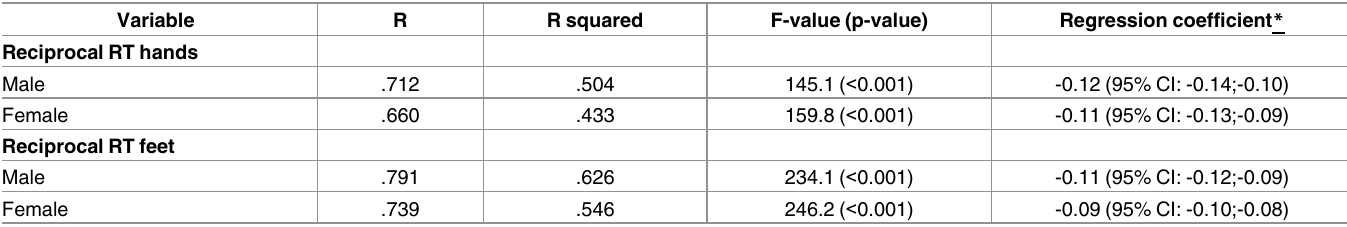
Table 3. Linear regression models for reaction time and age.